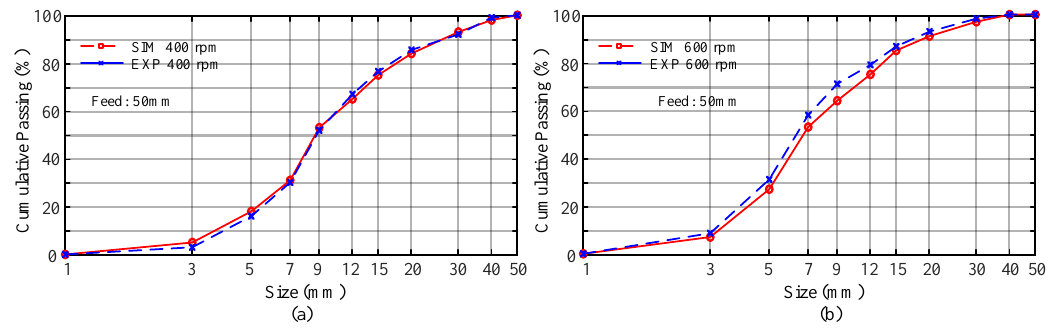
Figure 18. Comparison of the simulated and measured product size distribution for ( a ) 400 rpm and ( b ) 600 rpm.